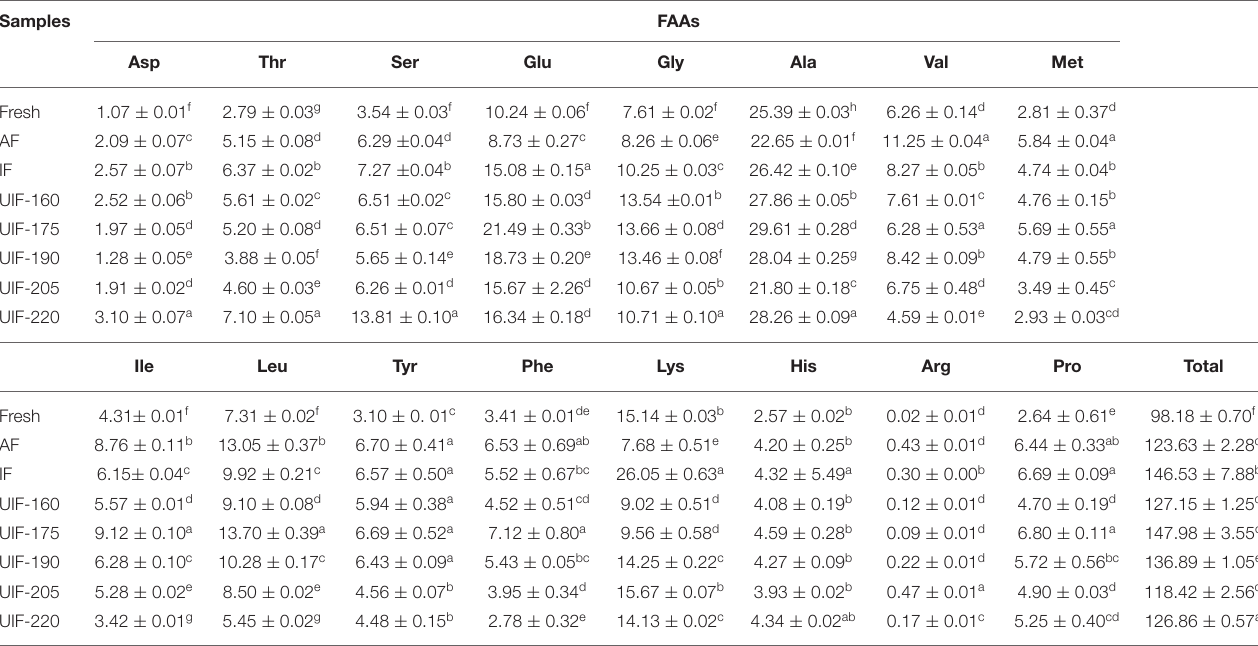
TABLE 3 | Influence of different freezing treatments on the free amino acids (FAAs) content (mg/100g) of the large yellow croaker.